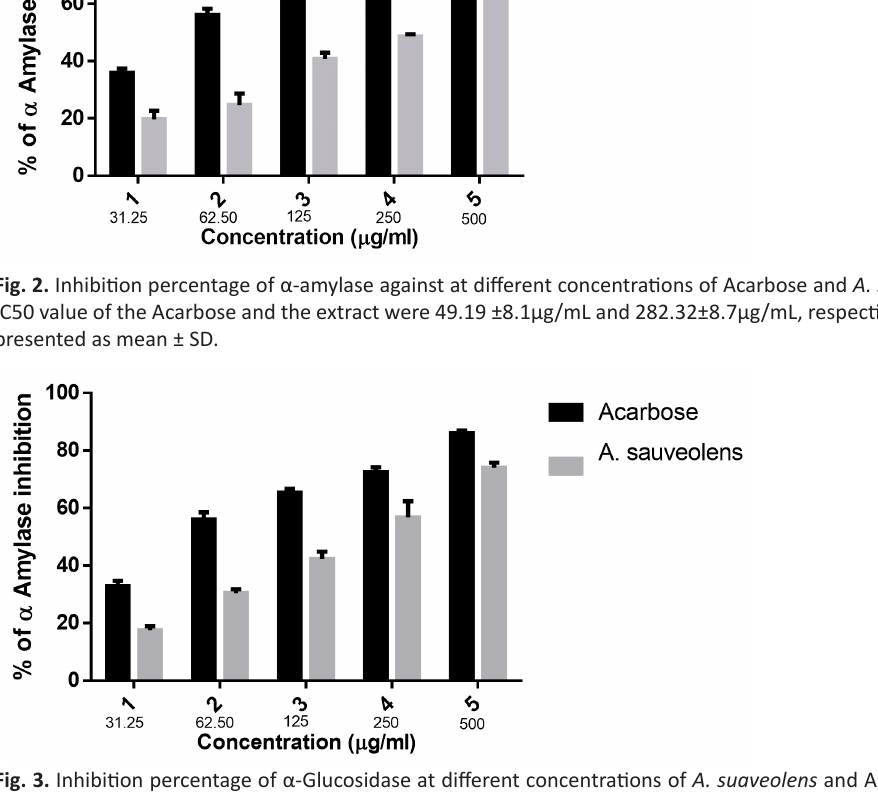
Fig. 3. Inhibition percentage of α-Glucosidase at different concentrations of A. suaveolens and Acarbose; Values are presented as mean ±